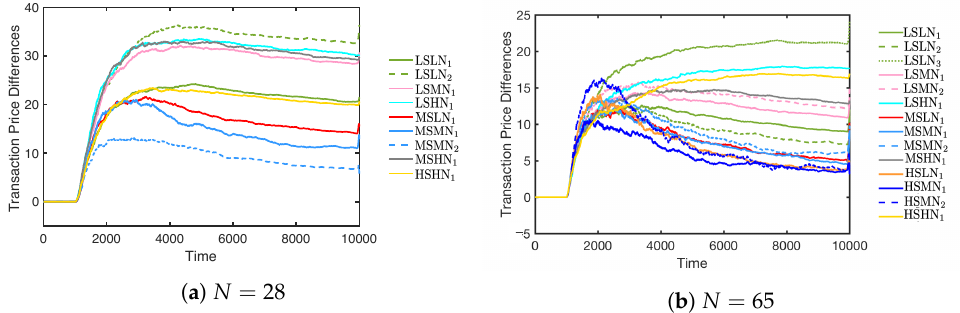
Figure 6. Transaction price differences throughout the trading horizon with and without a spoofer against each HBL-and-ZI equilibrium found in non-spoofing games (Section 5.2). Multiple curves for the same market environment represent different equilibria. The designed spoofing tactic clearly raises market prices when HBL are present. The effect attenuates over time, generally more quickly in the thicker market